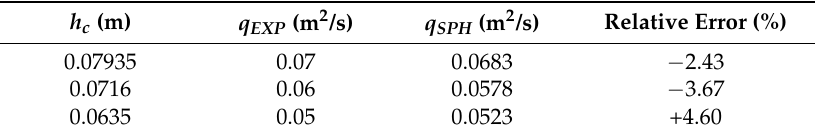
Table 1. Comparisons between experimental and parallelSPHysics discharge per unit width.